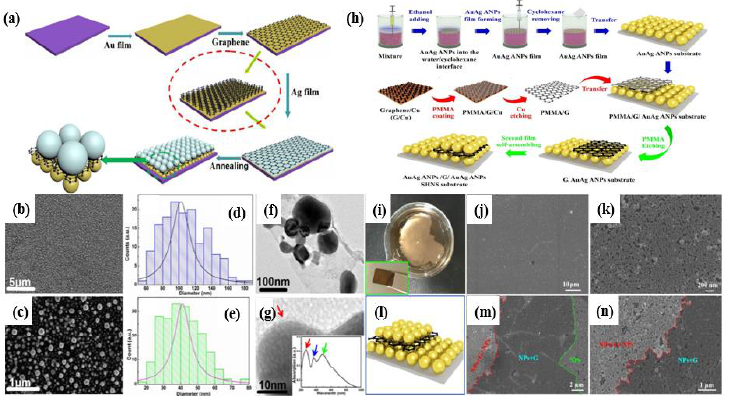
Figure 5. ( a ) Scheme illustration of the preparation process for Ag NPs/graphene/Au NPs structure. ( b , c ) The SEM image of Ag NPs/graphene/Ag NPs structure. ( d , e ) Diameter distribution of Ag NPs and Au NPs. ( f ) TEM image of the Ag NPs/graphene. ( g ) TEM image of graphene/Au NPs (Insert: the absorption spectrum of Au NPs/graphene/Au NPs. Reprinted from Ref. [55] with permission of 2018 Elsevier. ( h ) Schematic illustration of the preparation process for the AuAg NPs/graphene/AuAg NPs structure. ( i ) Picture of formatting monolayer AuAg NPs film on water/cyclohexane interface. ( j , k ) Different magnification SEM image of single-layer AuAg NPs array on Si substrate. ( l ) Schematic diagram of AuAg NPs substrate. ( m , n ) The low and high-magnification Sem images of AuAg NPs/graphene/AuAg structure formed on Si substrate. Reprinted from Ref. [79] with permission of 2020 Royal Society of Chemistry.